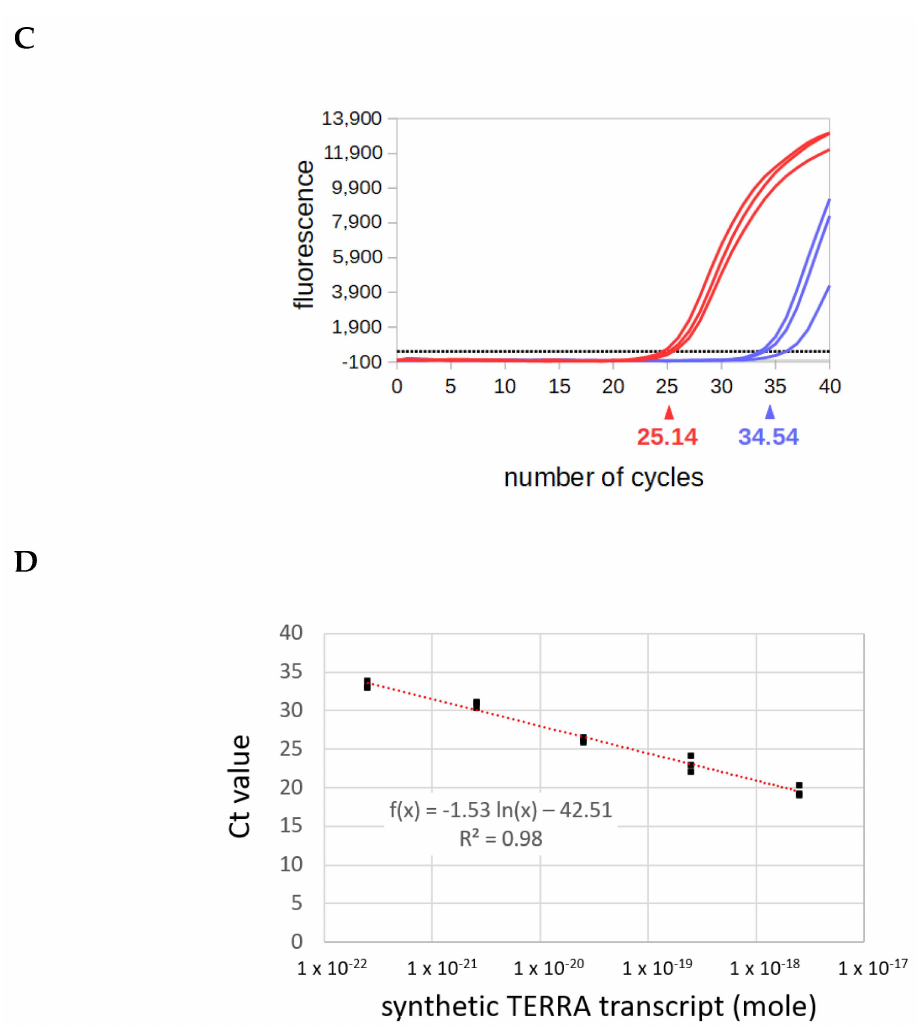
Figure 3. Validation of the AP-TSS method. ( A ) Schematic illustration showing locations of OT and OTC bound to the cDNA obtained by reverse transcription of synthetic TERRA with RP-TERRA. ( B ) Synthetic TERRA was reverse transcribed (RT) (lanes 1 and 3) or not (lanes 2 and 4), using RP-TERRA as a primer. Elongation was carried out using OT or OTC. Elongation products were amplified by PCR using P1 and P-TERRA, and PCR products (130 bp and 102 bp, arrowhead on the right) were run on a 2% EtBr-agarose gel. Lane M is the 50-bp DNA ladder (New England BioLabs). ( C ) Amplification plot of a qPCR assay after elongation step performed with OT or OTC. 2.10 -18 moles of synthetic TERRA was reverse transcribed using RP-TERRA as primer, the elongation of the cDNA was performed by OT or OTC and 1 / 15 of samples was used for the qPCR with P-TERRA and P1 primers. Graph shows the fluorescence as a function of the number of PCR cycles for three samples elongated with OT (red curves) or OTC (blue curves). The black dashed line corresponds to the threshold. The average Ct value for samples elongated with OT and OTC are indicated in red and blue, respectively. ( D ) Five dilutions of synthetic TERRA transcript were reverse transcribed using RP-TERRA as primer, the elongation of the cDNA was performed by OT and 1 / 70 of each sample was used for the qPCR with P-TERRA and P1 primers. Graph shows the triplicates of Ct values as a function of the logarithm of the corresponding synthetic TERRA quantity (in moles). The equation and R 2 of the regression line (in red) are indicated. Two possible events could explain the weak 102-bp product obtained with OTC. First, OTC (cid:48) may have hybridized to rare molecules of cDNA with a 3 end complementary to OTC; this could have been the case if the RNA was partially degraded, or if reverse transcription was not complete. (cid:48) Second, OTC might be elongated despite blocking of the 3 terminus by dideoxycytidine. This